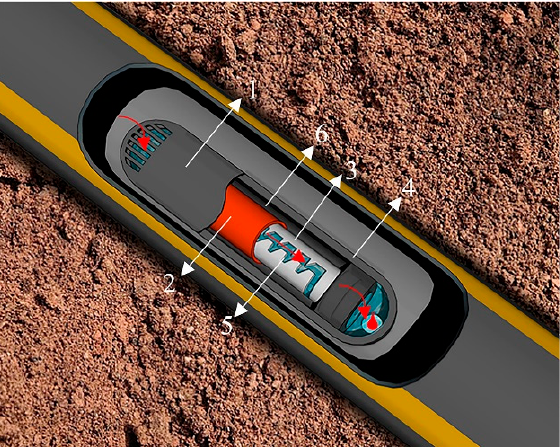
Figure 1. Schematic illustration of variable flow emitter structure. Note: 1. Shell body; 2. Cylindrical elastomer; 3. Core body; 4. Base part; 5. Flow channel; 6. Cavity body.